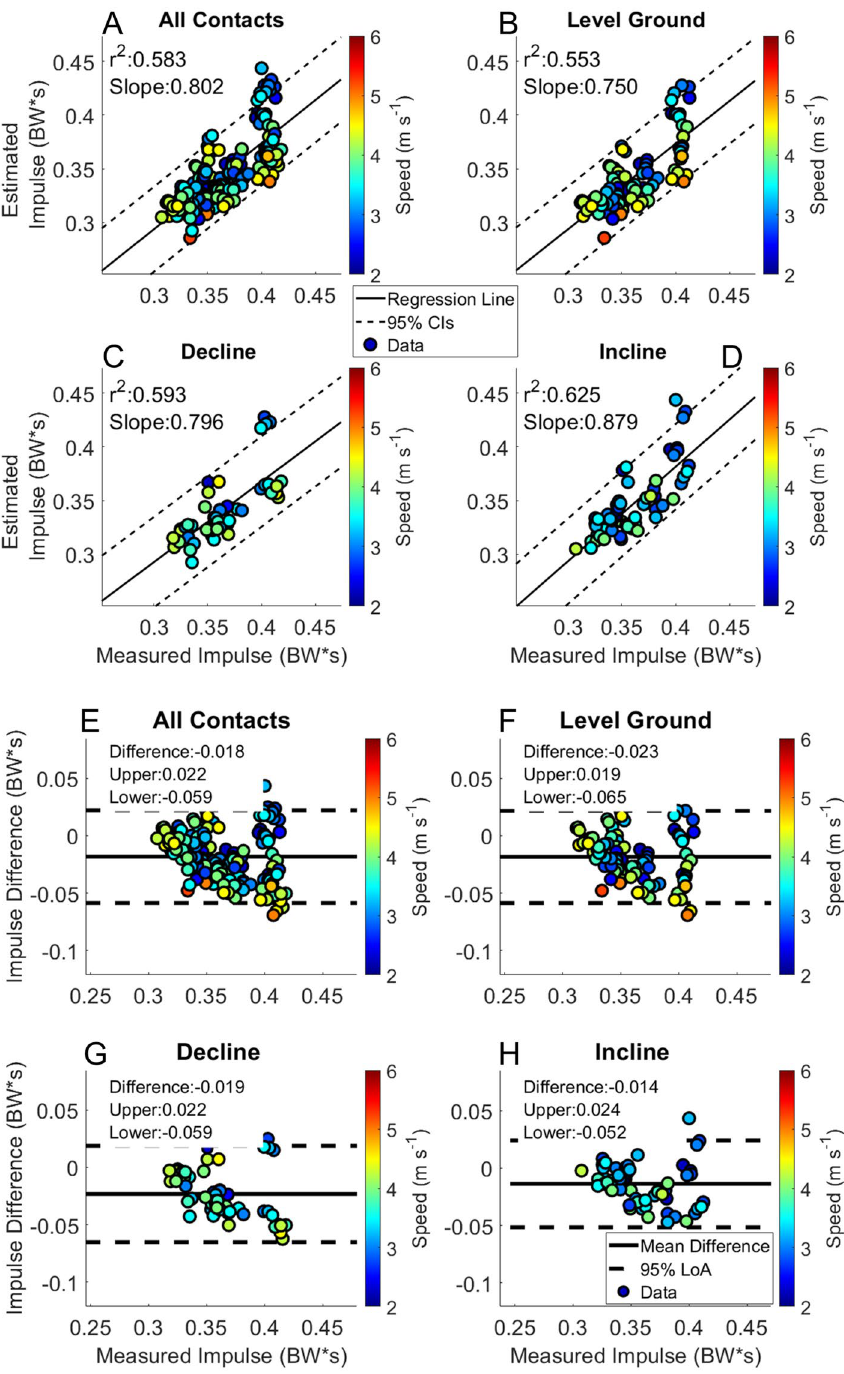
Figure 8. Impulse. Linear regression and Bland–Altman plots are presented for all foot contacts ( A and E ), followed by level ground ( B and F ), decline ( C and G ) and incline foot contacts ( D and H ). Pearson Correlation Coefficients and the slope of the regression line are presented in panels ( A – D ). The Bland–Altman plots present differences between the estimated and measured stance average GRF. The average difference and the 95% LoA are shown in panels ( E – H